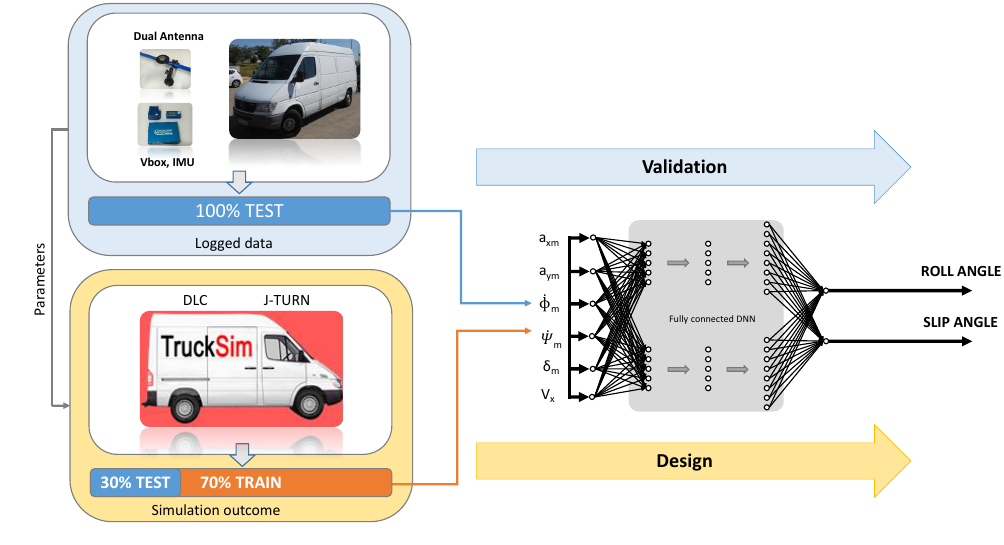
Figure 1. Training and validation